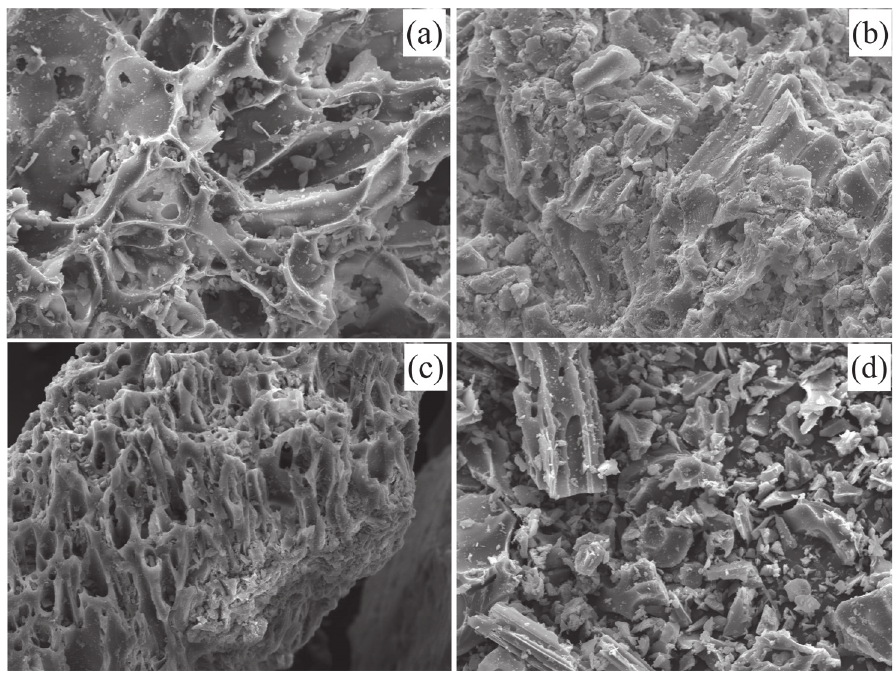
Figure 2: SEM micrographs of the volcanic ash studied (mag. 500x): (a) PVA 40, (b) PVA 40-60, (c) PVA 60-100, and (d) PVA